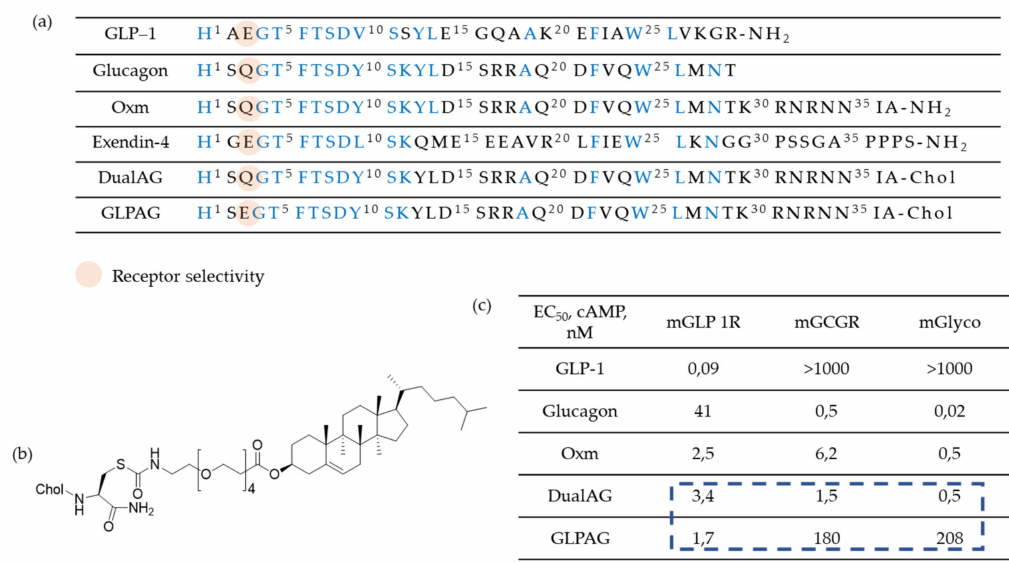
Figure 6. ( a ) Sequence alignment and receptor agonist potencies of Oxyntomodulin (OXM) and related peptides. Conserved residues are highlighted: ( b ) Structure of a Glucagon-Like Peptide 1 / Glucagon Receptor Dual Agonist and ( c ) in vitro receptor agonist potencies (cAMP release) against mGLP1R and mGCGR and ED 50 (nM) in the ex vivo mouse liver glycogenolysis assay (mGlyco).